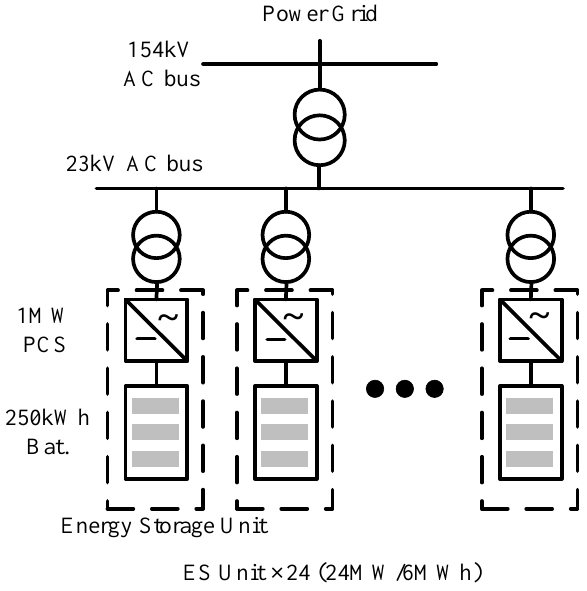
Figure 1. General energy storage system (ESS) structure for frequency regulation.